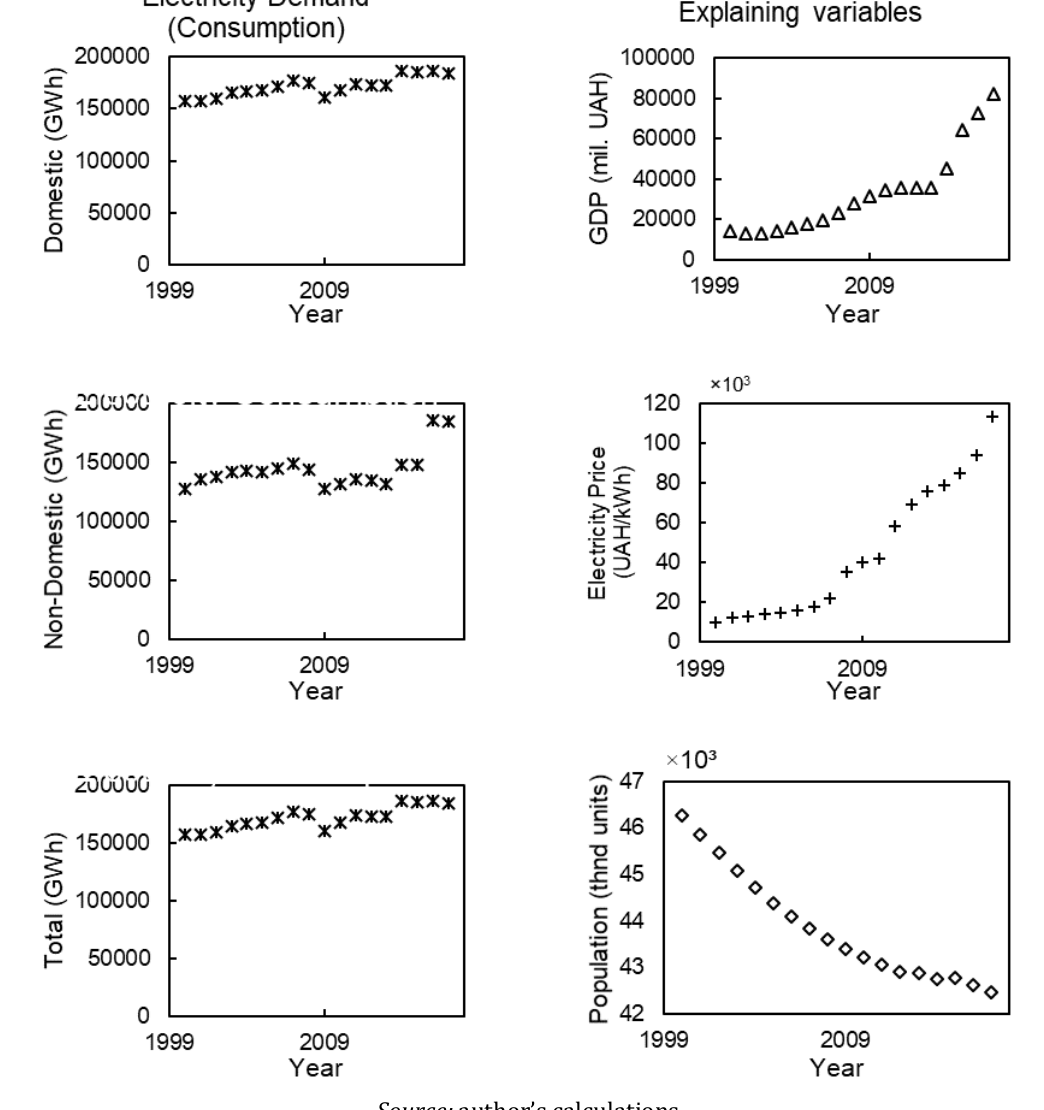
Table 1: Correlation matrix for the studied variables used in multiple linear regression